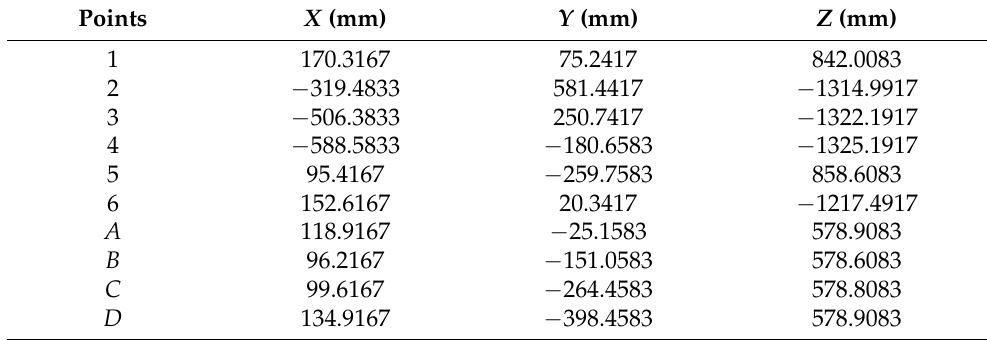
Table 7. The object space coordinates of second experiment.